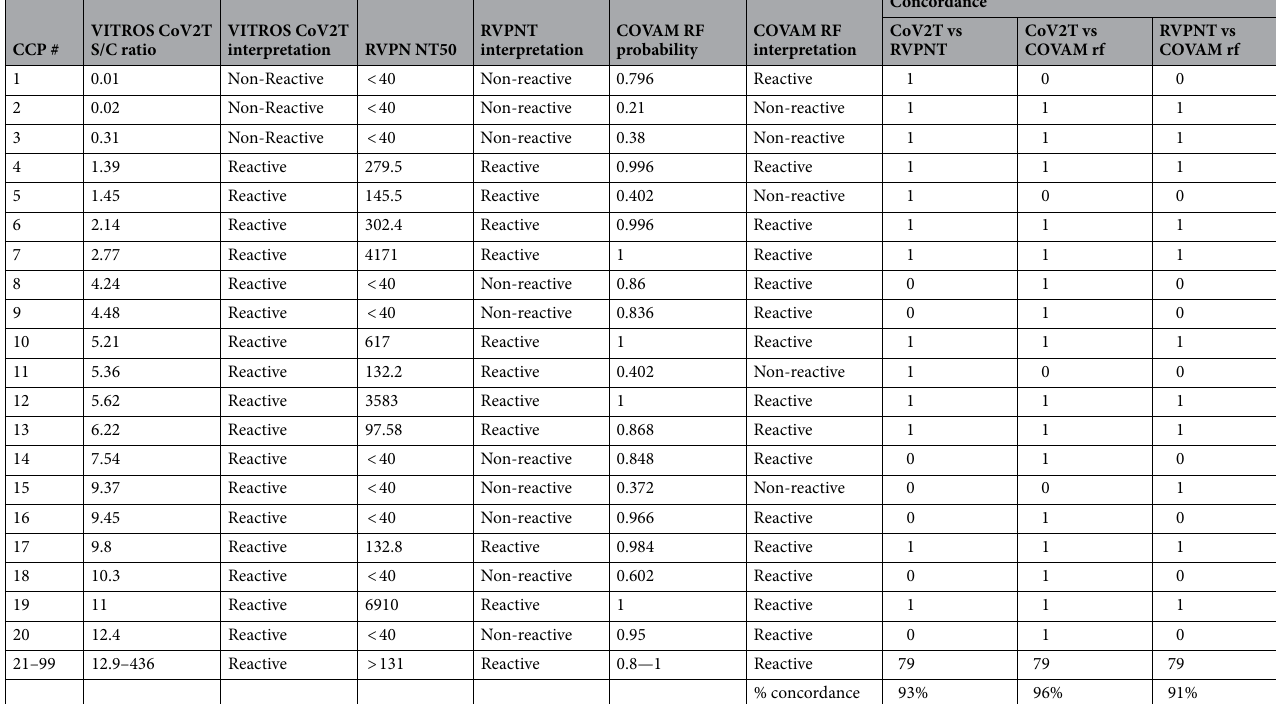
Table 1. Reactivity classification of the CCP samples. CCP samples were analyzed by the COVAM array as well as the VITROS CoV2T chemiluminescence and RVPNT assays. The results from the two computational methods as well as VITROS and RVPNT assays show high concordance, especially for the high titer samples. A higher concordance (96%) was observed between the VITROS assay and COVAM